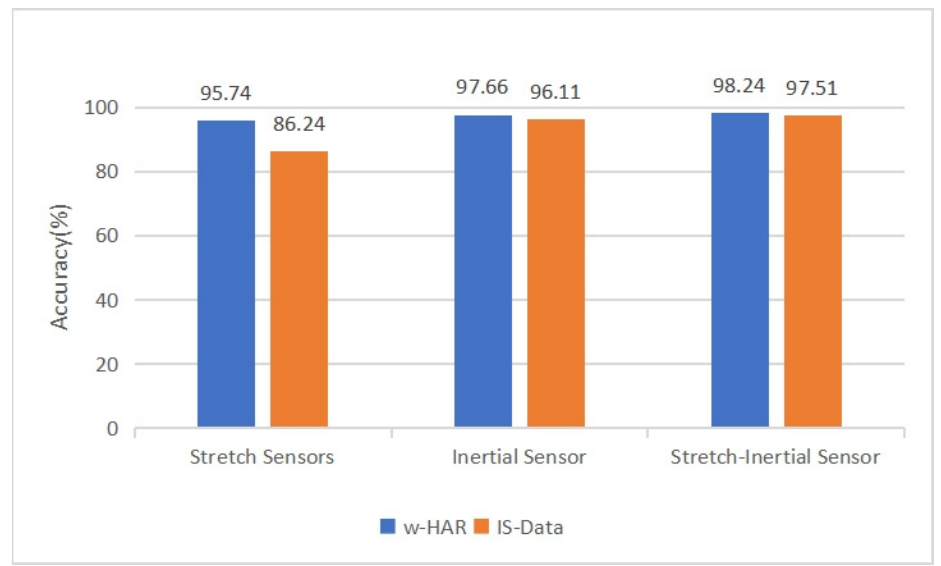
Figure 11. Accuracy of the three types of data in the w-HAR dataset and the IS-Data dataset.